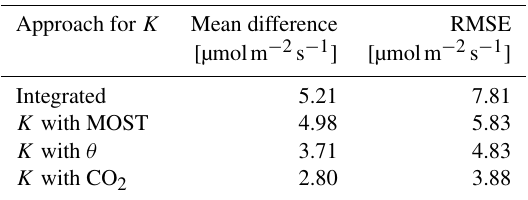
Table 2. The mean difference and the root mean square error (RMSE) of the comparison between the EC CO 2 flux measurements at 27m in the tower and the CO 2 flux calculated with different meth- ods for the exchange coefficient K , based on the ICOS data, each using the vertical gradient of CO 2 at 23m and 125m of our cam- paign